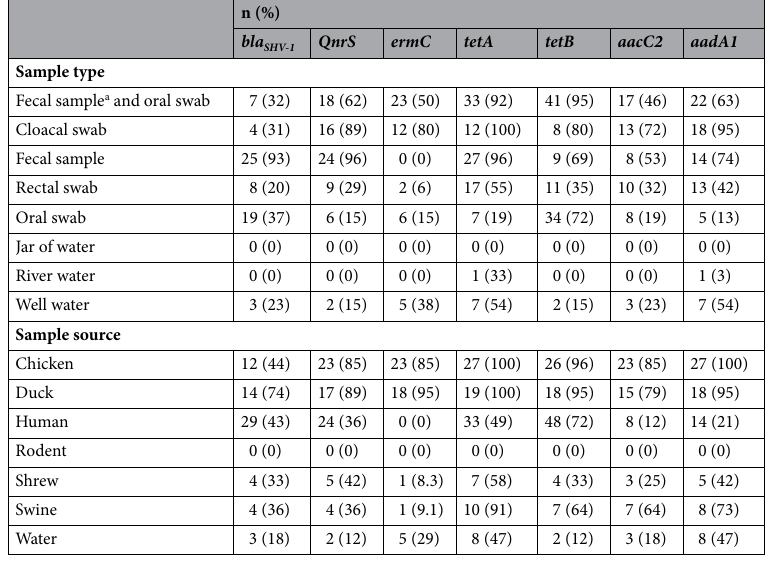
Table 1. Specimens positive for seven antibiotic resistance genes of public health importance in an urban informal settlement in Kathmandu, Nepal, 2017. A total of 218 specimens from 161 individuals were tested, including: humans (n = 88), chickens (n = 47), ducks (n = 35), swine (n = 11), water (n = 17), rodents (n = 8), and shrews (n = 12). A subset of data (n = 161) was used in analyses, where within-individual samples were collapsed and counted as positive for both oral and fecal sampling if both of the two samples (fecal or oral) were positive for a particular resistance gene, and otherwise categorized according to whether the oral or fecal sample was positive. a Fecal samples comprise rectal swabs (swine, rodents, shrews), cloacal swabs (ducks, chickens), and feces